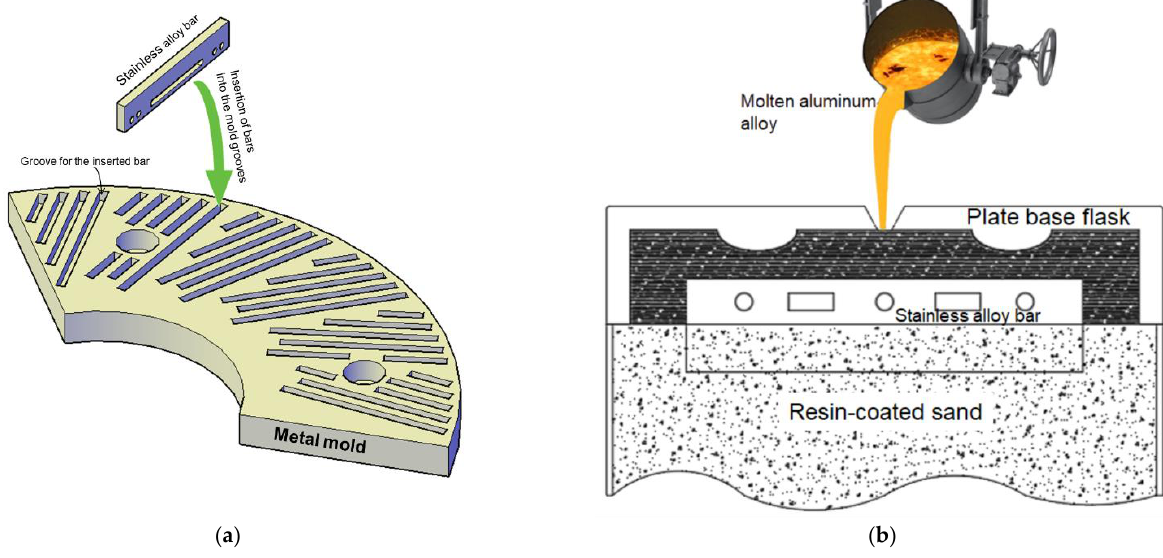
Figure 2. Manufacturing process for the refiner plate without a draft angle: ( a ) Bar insertion process to a metal mold; ( b ) Flask for the